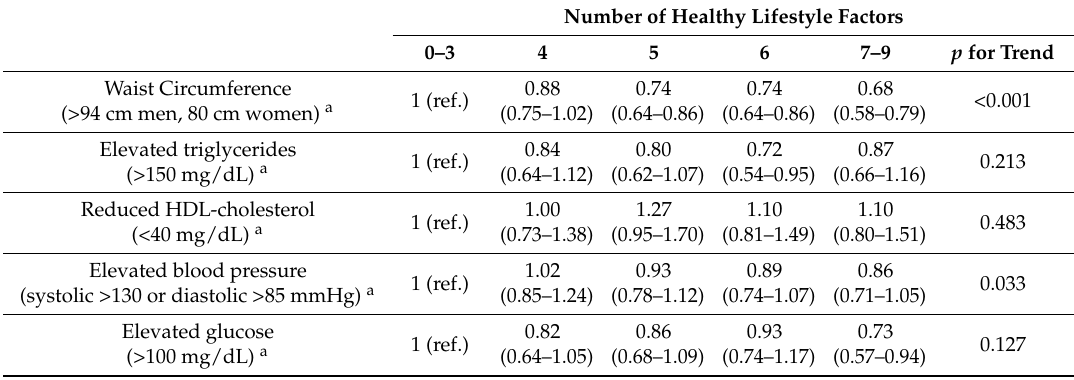
Table 4. Odds ratios and 95% confidence intervals for each component of metabolic syndrome at the 6-year follow-up, according to the number of HLFs (the SUN Cohort).